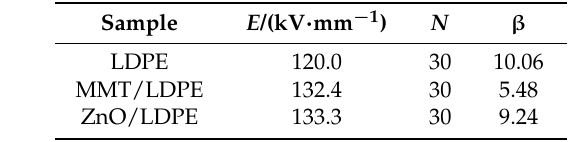
Table 3. Weibull distribution parameters (25 ◦